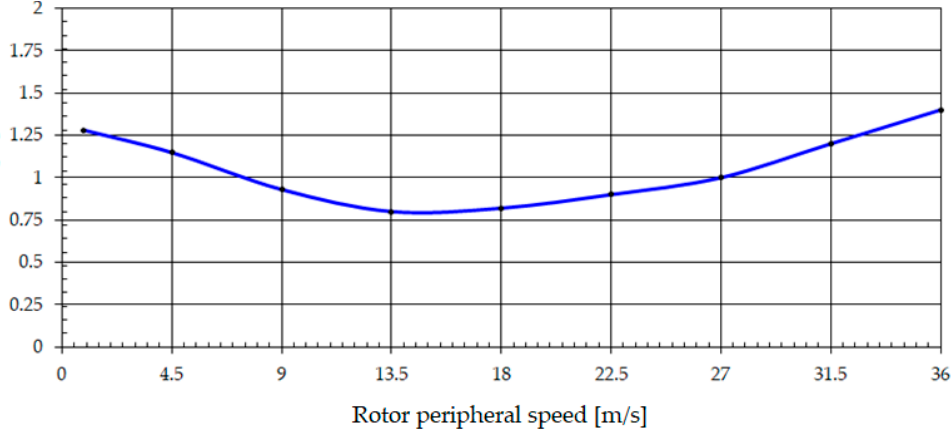
Figure 6. The variation of losses ( p ) depending on the rotor peripheral speed ( v p